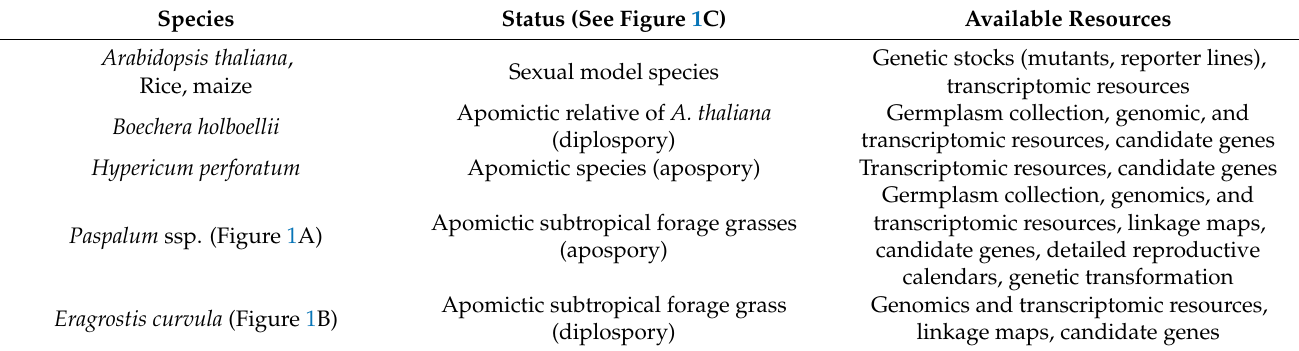
Table 1. Sexual and apomictic systems studied in Mechanisms of Apomictic Development (MAD). Species Status (See Figure 1C) Available Resources Arabidopsis thaliana , Genetic stocks (mutants, reporter lines), Sexual model species transcriptomic Rice, maize